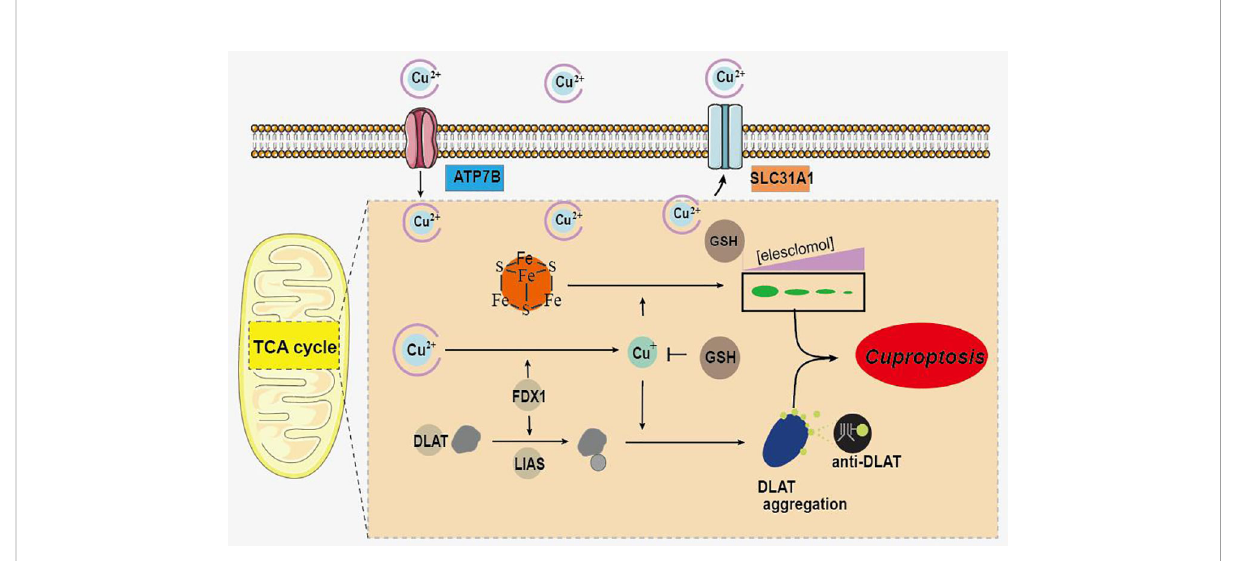
FIGURE 1 Schematic of mechanisms promoting